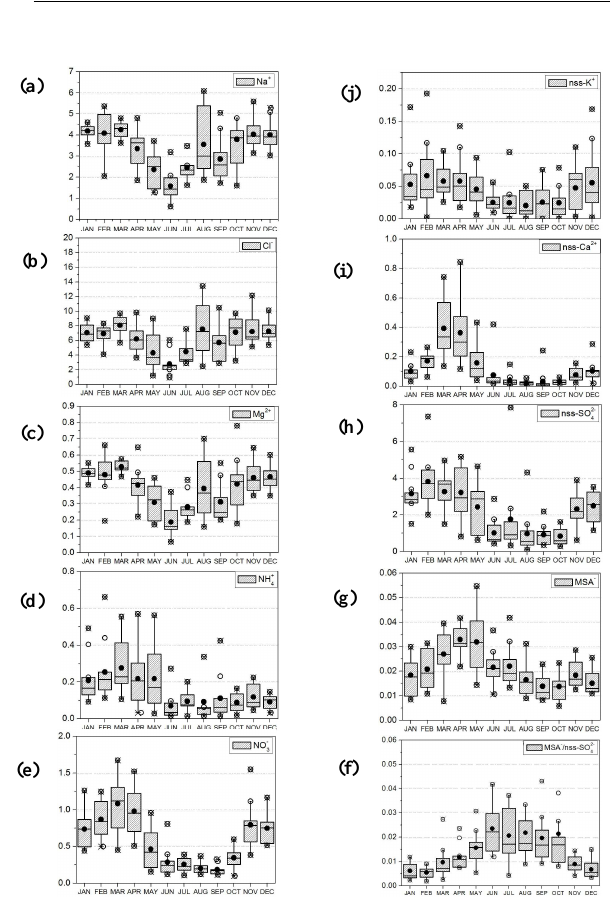
Figure 6. Box and whisker plots of monthly variations of differ- ent measured/derived ionic species (µgm − 3 ) and mass ratio for the period 2001–2012 over the western North